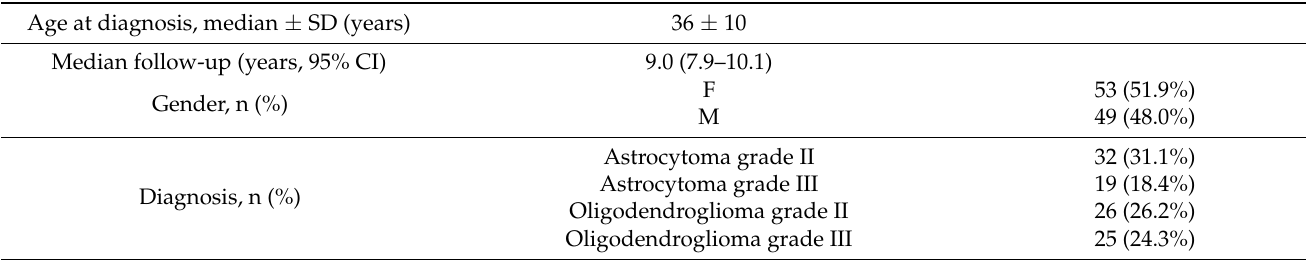
Table 1. Patient and tumour